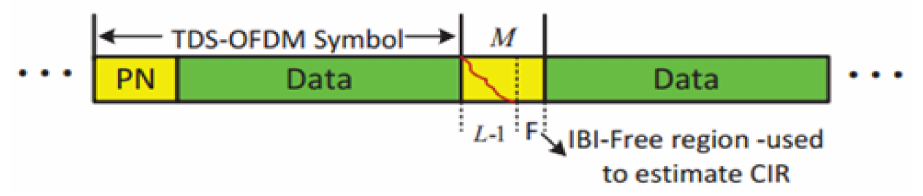
Figure 2. TDS-OFDM, the received TDS-OFDM